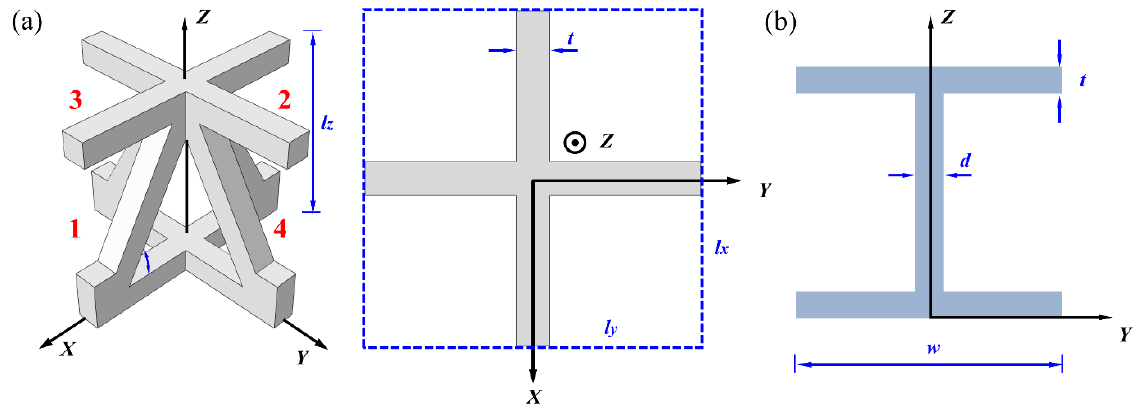
Figure 6. Schematic of the representative unit cell ( a ) and I-beam element ( b ).